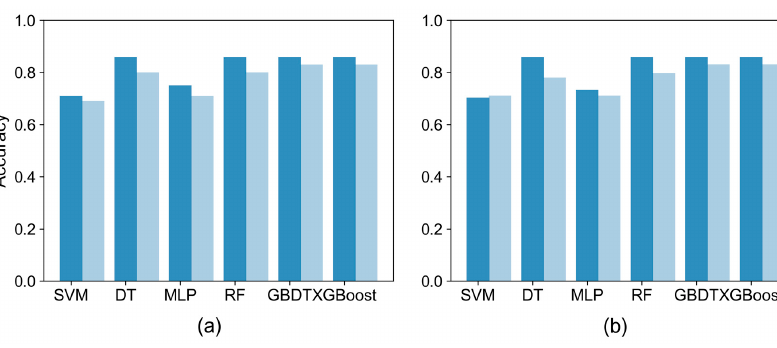
Figure 4. The performance (accuracy) for ( a ) model 1 ( 𝜆 , 𝜆 (cid:2929)(cid:2932) , (cid:3033)